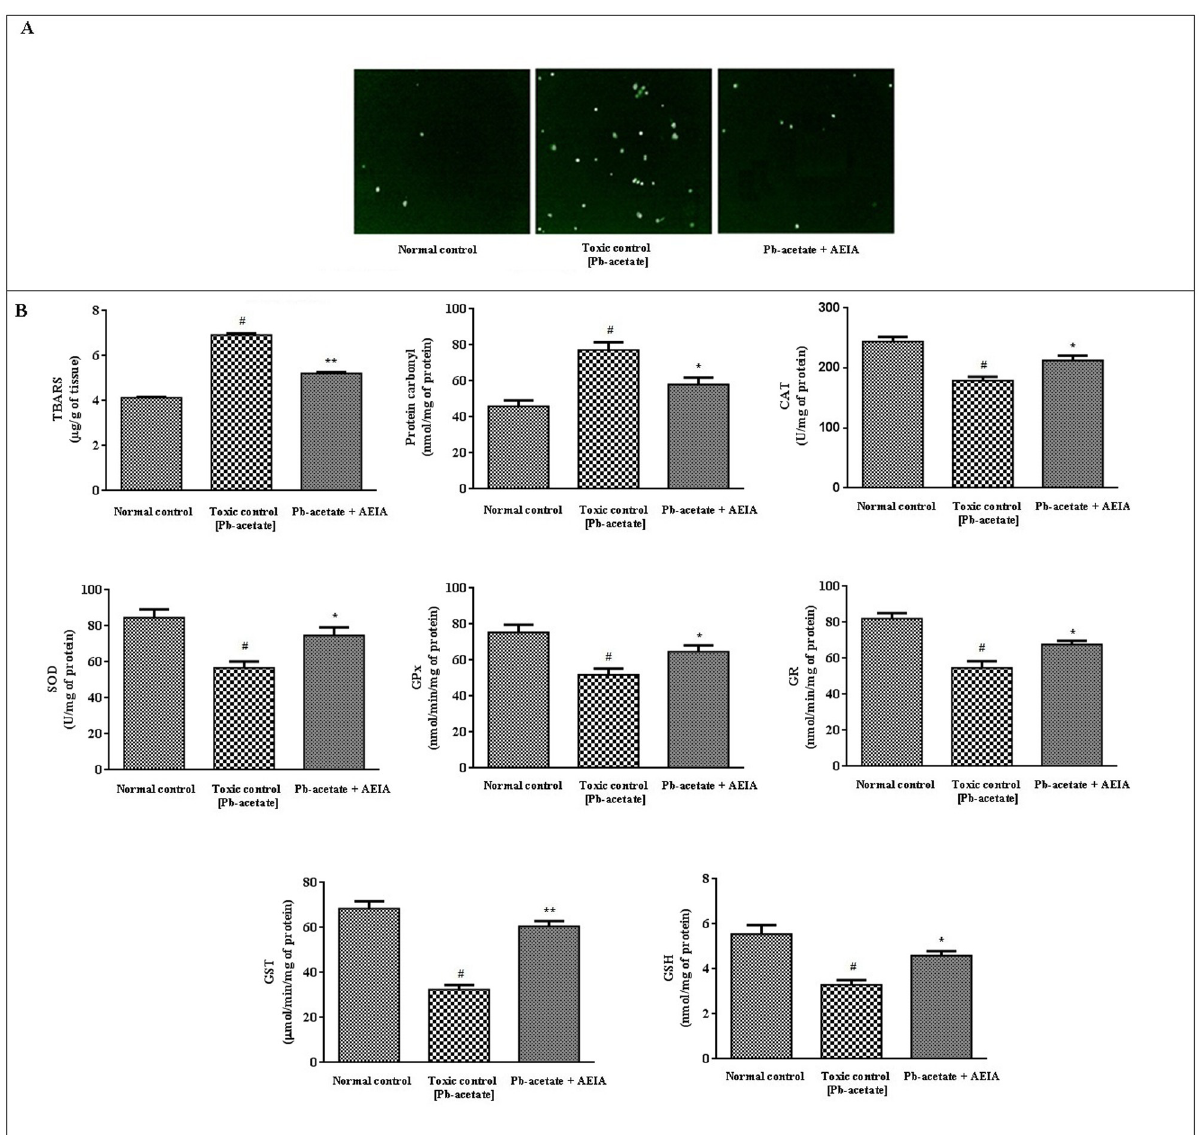
Fig 2. The effect on cellular redox markers in the absence (Pb-acetate) and existence of AEIA (Pb-acetate + AEIA) in murine hepatocytes. Panel A. Effect on ROS-generation (intrecellular) was measured by fluorescence microscopy (DCF-DA) in Pb-exposed hepatocytes in the absence (Pb-acetate) and existence of AEIA (Pb-acetate + AEIA). Panel B. Effect on antioxidant parameters viz. lipid peroxidation, protein carbonylation, SOD, CAT, GST, GPx, GSH and GR in the absence (Pb-acetate) and existence of AEIA (Pb-acetate + AEIA). Values are expressed as mean ± SE (n = 3). # Values differed significantly from normal control (p < 0.01). * Values differed significantly from pb-acetate control (p < 0.05). ** Values differed significantly from pb-acetate control (p < 0.01). SOD unit, “ U ” is defined as μ -moles inhibition of NBT-reduction/min while CAT unit “ U ” is defined as H 2 O 2